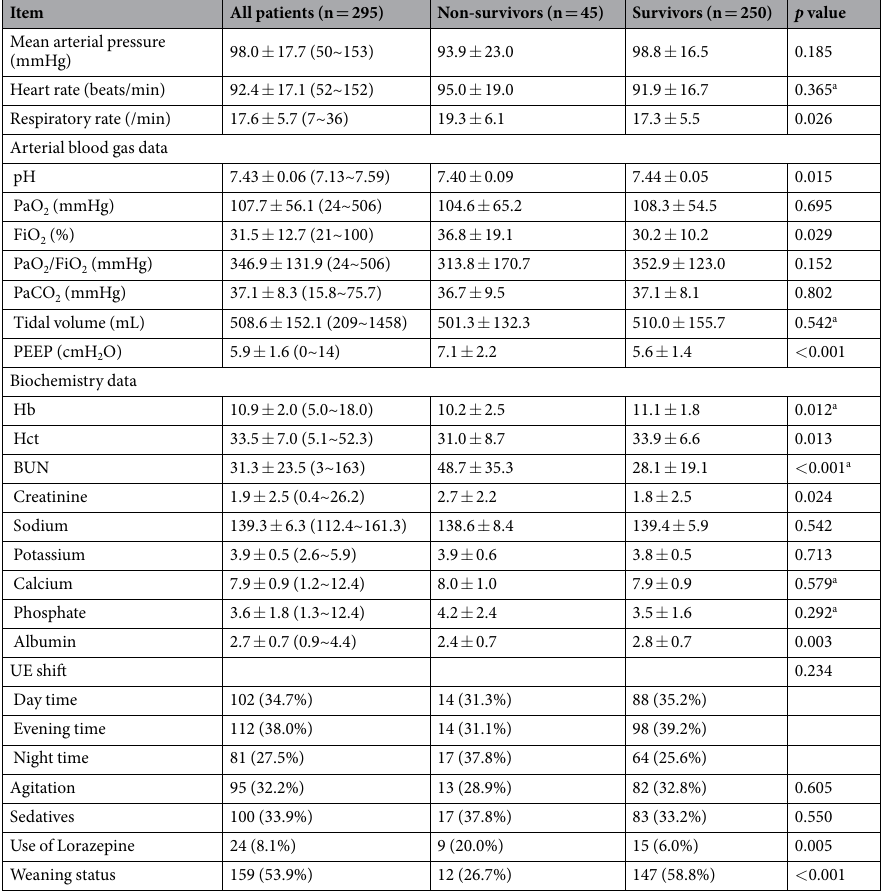
Table 2. Most recent data before extubation of different unplanned extubation (UE) groups. Expressed as mean ± SD (range) or n (%). a The Mann-Whiney U test was used owing to not being normally